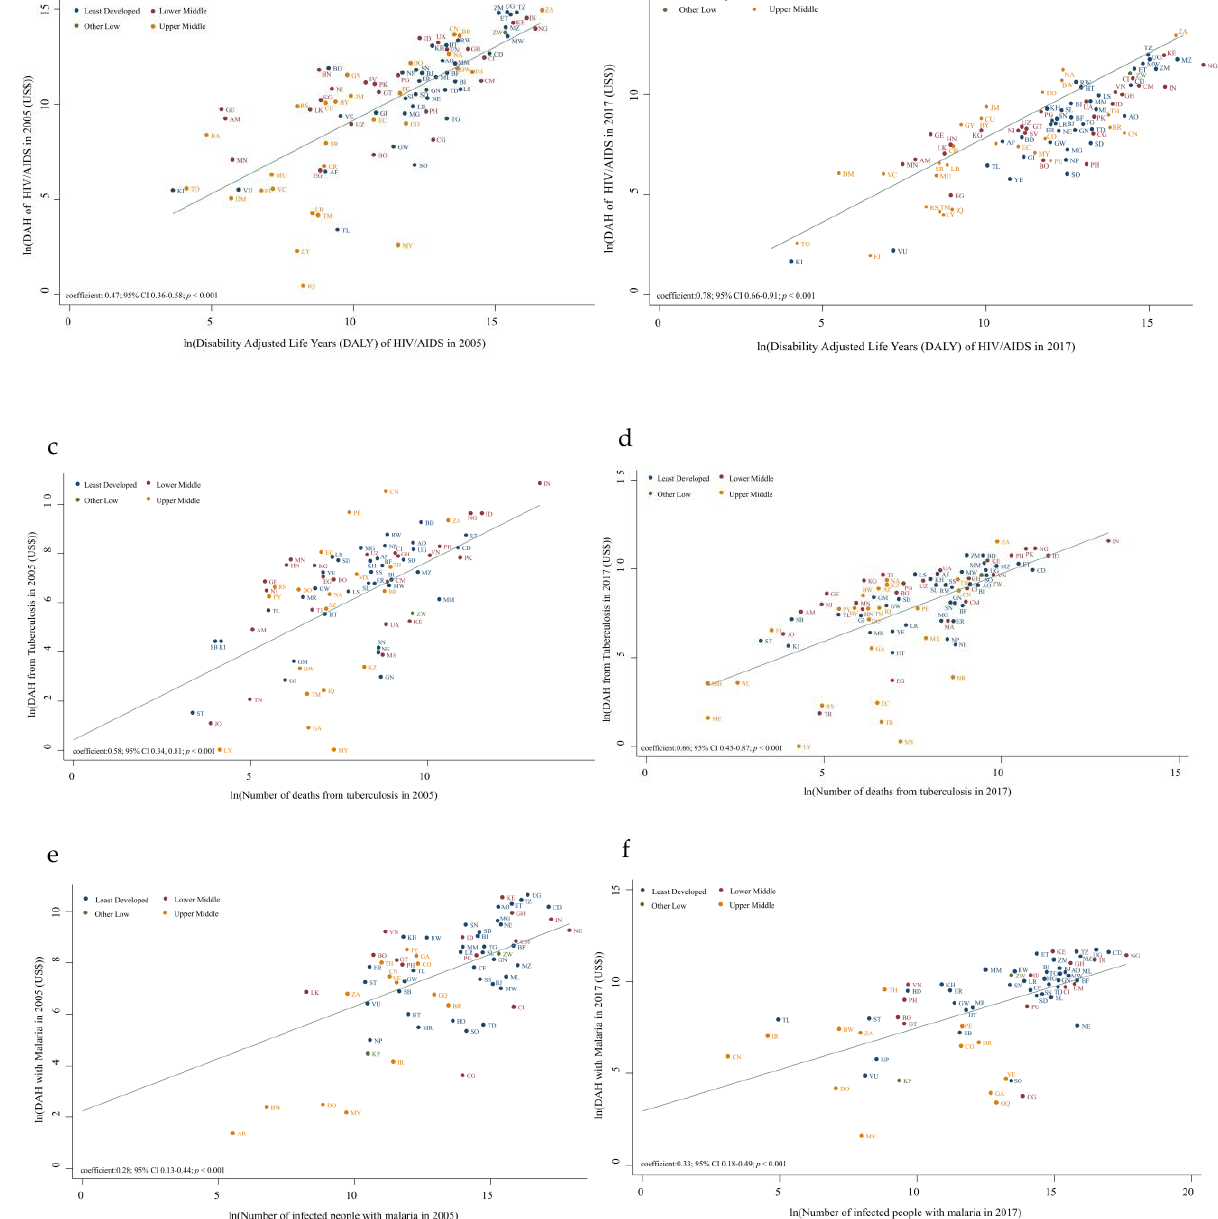
Figure 3. Associations between development assistance for health and disease burden ( x -axis: disease burden, log transformation, y -axis: DAH (USD), log transformation, income group classification by World Bank are colored). ( a ) DAH and Disability Adjusted Life Years (DALY) of HIV/AIDS in 2005. ( b ) DAH and Disability Adjusted Life Years (DALY) of HIV/AIDS in 2017. ( c ) DAH and number of deaths from tuberculosis (TB) in 2005. ( d ) DAH and number of deaths from TB in 2017. ( e ) DAH and number of infected people with malaria in 2005. ( f ) DAH and number of infected people with malaria in 2017. Afghanistan (AF), Albania (AL), Algeria (DZ), Angola (AO), Armenia (AM), Azerbaijan (AZ), Argentina (AR), Bangladesh (BD), Belarus (BY), Benin (BJ), Bolivia (BO), Bosnia and Herzegovina (BA), Botswana (BW), Brazil (BR), Burkina Faso (BF), Burundi (BI), Cambodia (KH), Cameroon (CM), Central African Republic (CF), Chad (TD), China (CN), Colombia (CO), Congo (CG), Costa Rica (CR), Cote d’Ivoire (CI), Cuba (CU), Democratic People’s Republic of Korea (KP), Democratic Republic of the Congo (CD), Djibouti (GI), Dominica (DM), Dominican Republic (DO), Ecuador (EC), Egypt (EG), El Salvador (SV), Equatorial Guinea (GQ), Eritrea (ER), Ethiopia (ET), Fiji (FJ), Gabon (GA), Gambia (GM), Georgia (GE), Ghana (GH), Guatemala (GT), Guinea